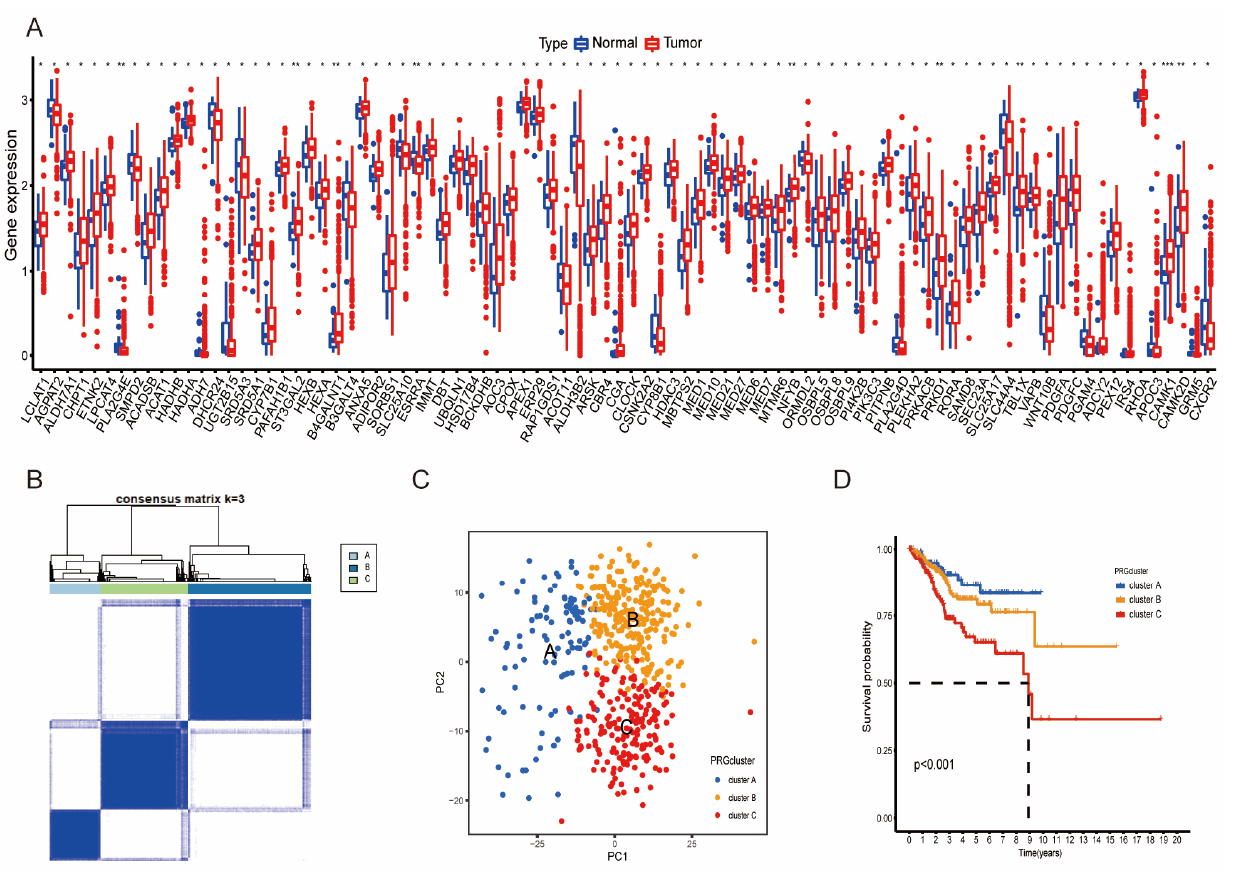
Figure 1. Identification and clustering of LMRGs: ( A ) expression of 88 DE-LMRGs between the UCEC samples and normal samples. * p < 0.05, ** p < 0.01, and *** p < 0.001. ( B ) Consensus clustering map of NMF clustering, and the optimal cluster number was three (k value = 3). ( C ) Principal com- ponent analysis (PCA) showed that the three clusters in the consensus clustering approach were robustly segregated. ( D ) Kaplan–Meier curve survival (K–M) analysis of patients in the three clus- ters, and patients in Cluster A had a better prognosis. p < 0.001.